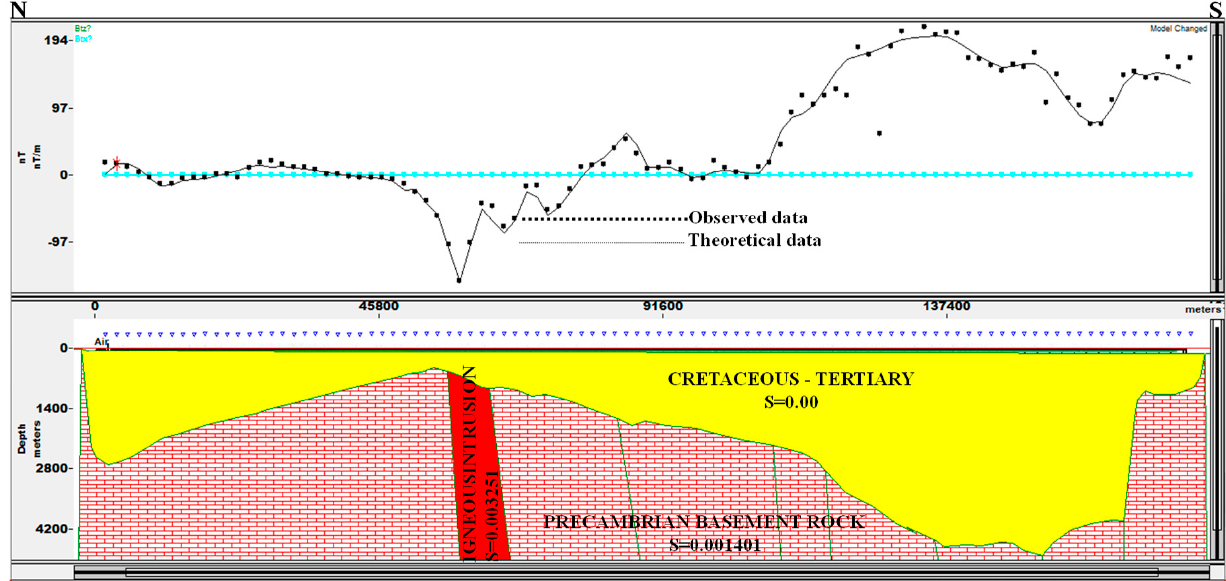
Figure 7. 2-D total magnetic intensity model obtained at Profile 3 showing thickness of sediments, basement and igneous rocks, and their respective susceptibility values.